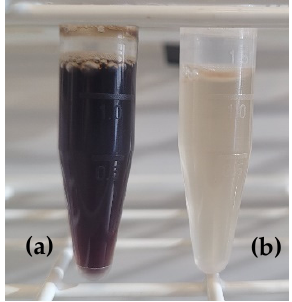
Figure 2. Porcine cruor raw hydrolysate ( a ) and discolored hydrolysate ( b ).